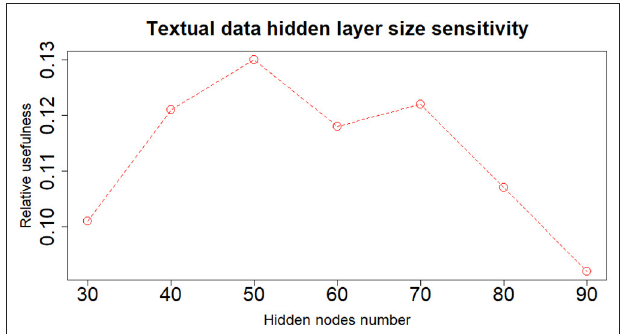
FIGURE 3 | Numerical data—sensitivity analysis on the number of nodes of the hidden layer.